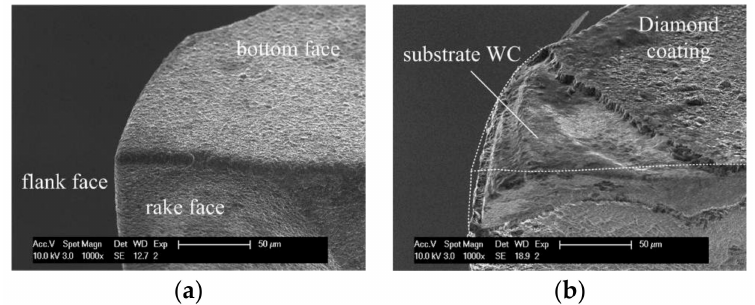
Figure 8. Comparison of ( a ) a new tool edge and ( b ) a typical worn out tool